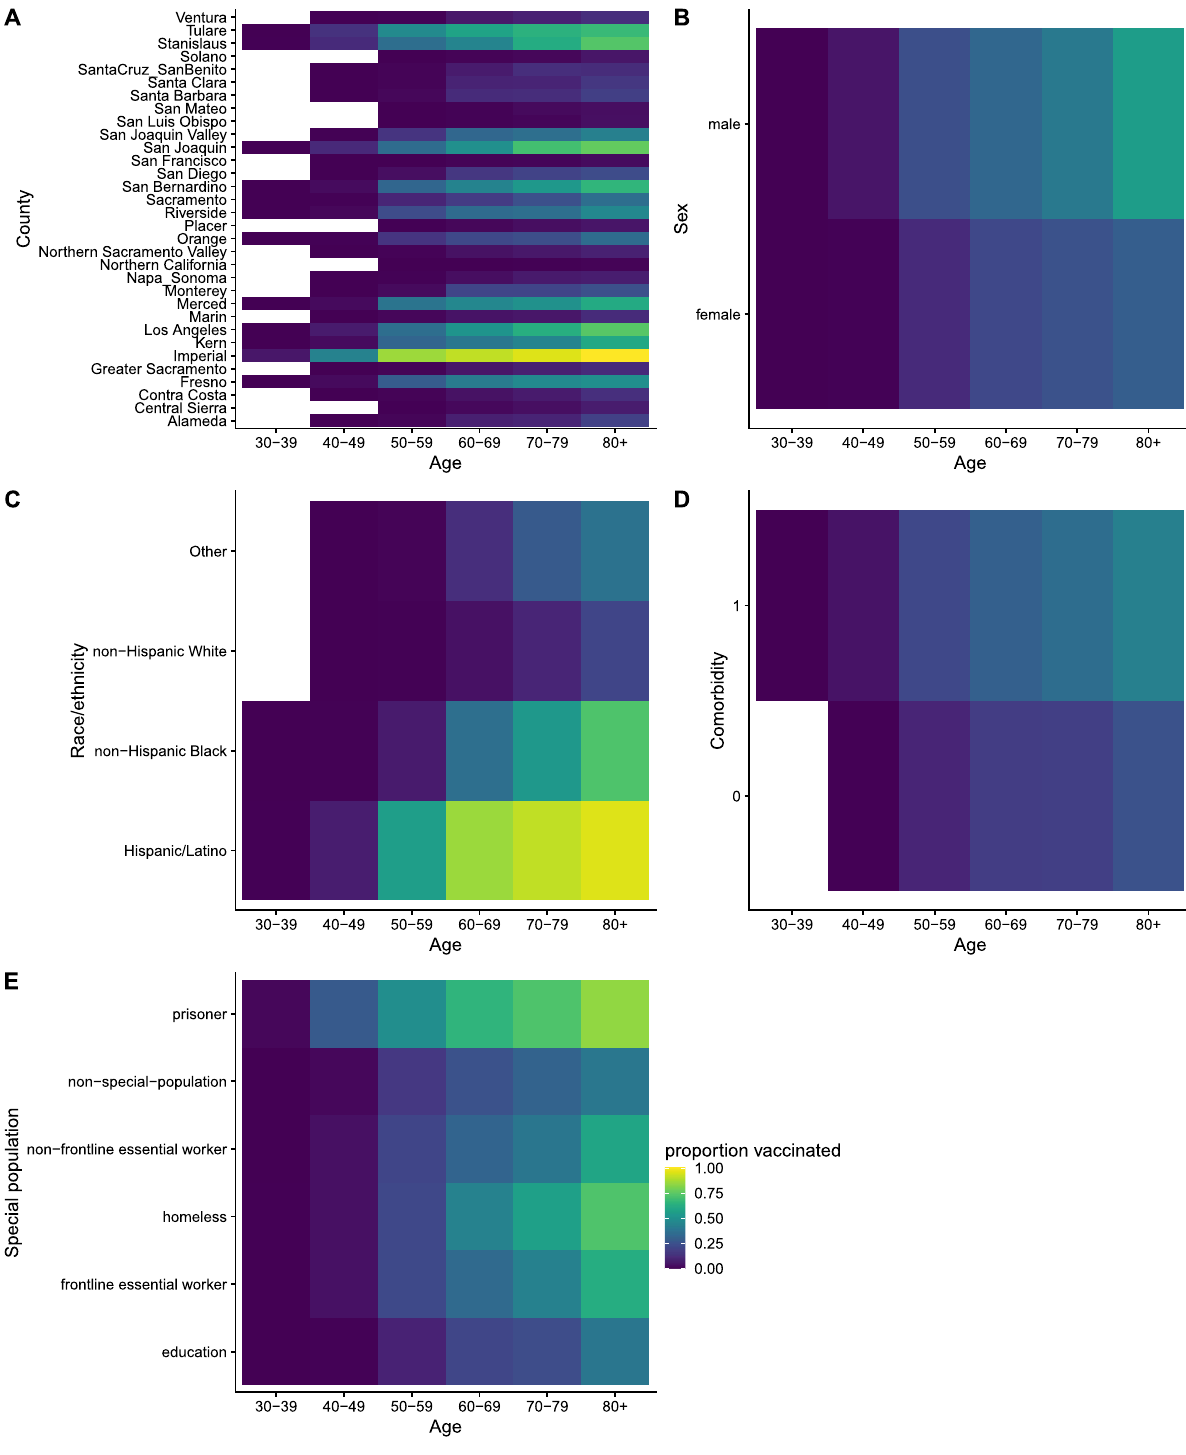
Figure 4. Optimal vaccine allocation under simultaneous targeting by multiple risk factors. Plots show the proportion of individuals in each ( A ) age-and-county group, ( B ) age-and-sex group, ( C ) age-and-race/ethnicity group, ( D ) age-and-comorbidity-status group, and ( E ) age-and-special population group vaccinated under optimal distribution of the first 5 million vaccinations in California. Lighter yellow colors show where higher proportions of individuals are vaccinated, darker blue colors where lower proportions of individuals are vaccinated. We assume all healthcare workers, skilled nursing facility residents and assisted living facility residents are vaccinated first before essential workers and other groups as per the US CDC recommendation. Vaccinations are optimally allocated to avert DALYs across all risk factors (demographic, special population, and comorbidities). Comorbidity status is treated as binary (0 = no comorbidity, 1 = any comorbidity). The proportions of individuals vaccinated under optimal vaccine distribution for each of the individual risk factors are shown in Figure